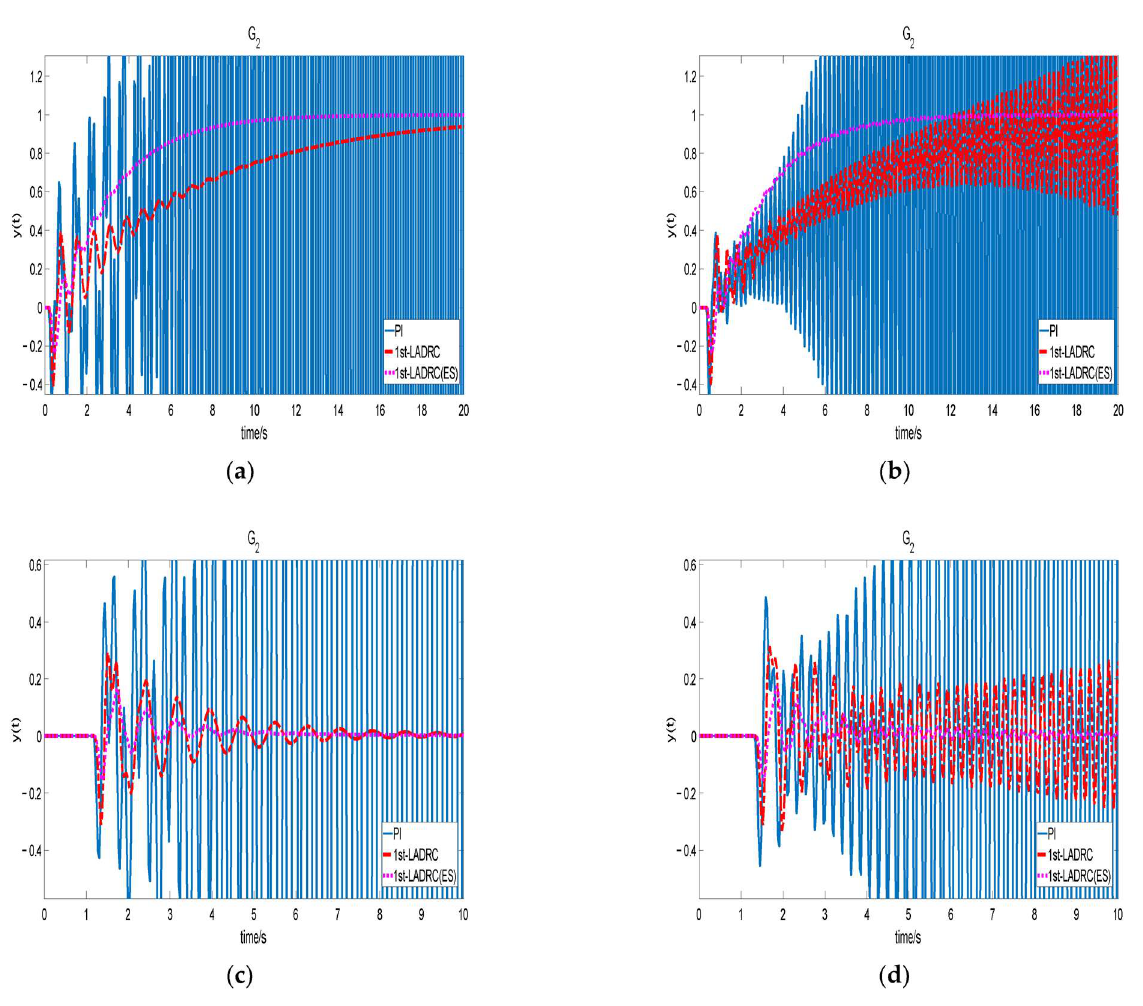
Figure 11. The response of G 2 under PI and LADRCs with different time delays. Step response curve when τ decreases by 30% ( a ) and increases by 30% ( b ). Disturbance response curve when τ decreases by 30% ( c ) and increases by 30% ( d ).